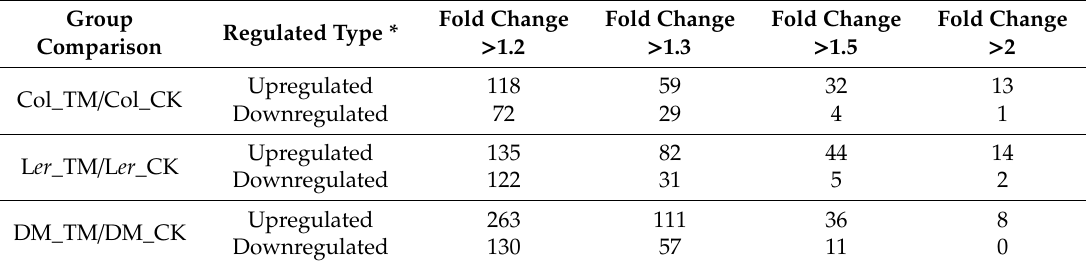
Table 1. Summary of number of di ff erentially expressed proteins for each comparison.